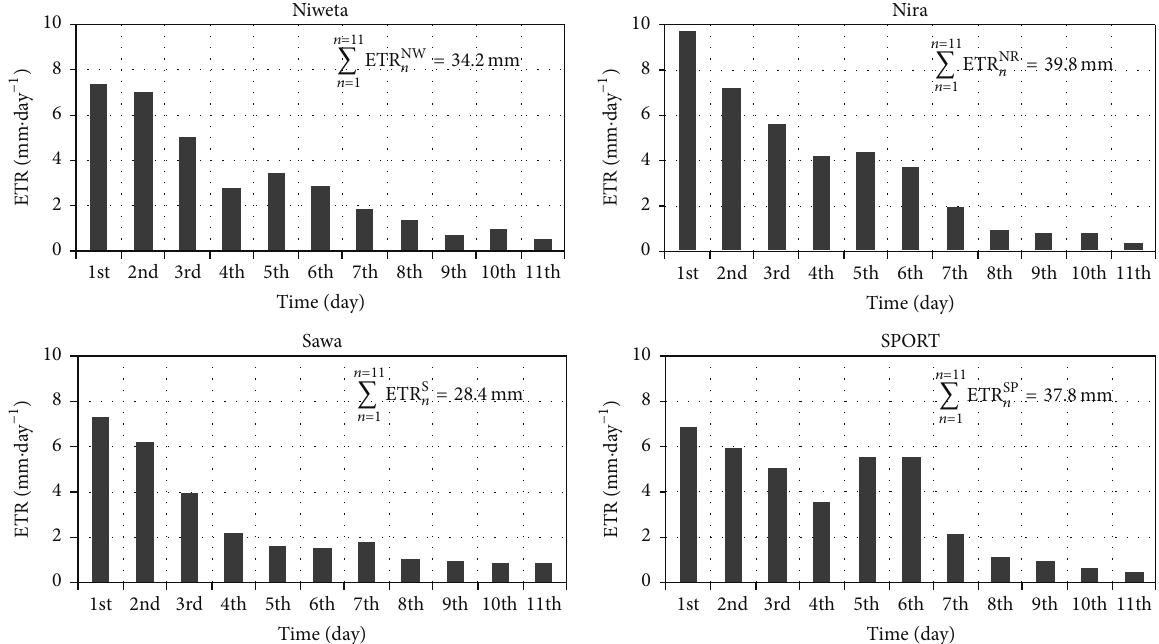
Figure 4: Dynamics of diurnal evapotranspiration in the period of 11–21.06.2013; ETR 𝑛 is evapotranspiration on 𝑛 th day.